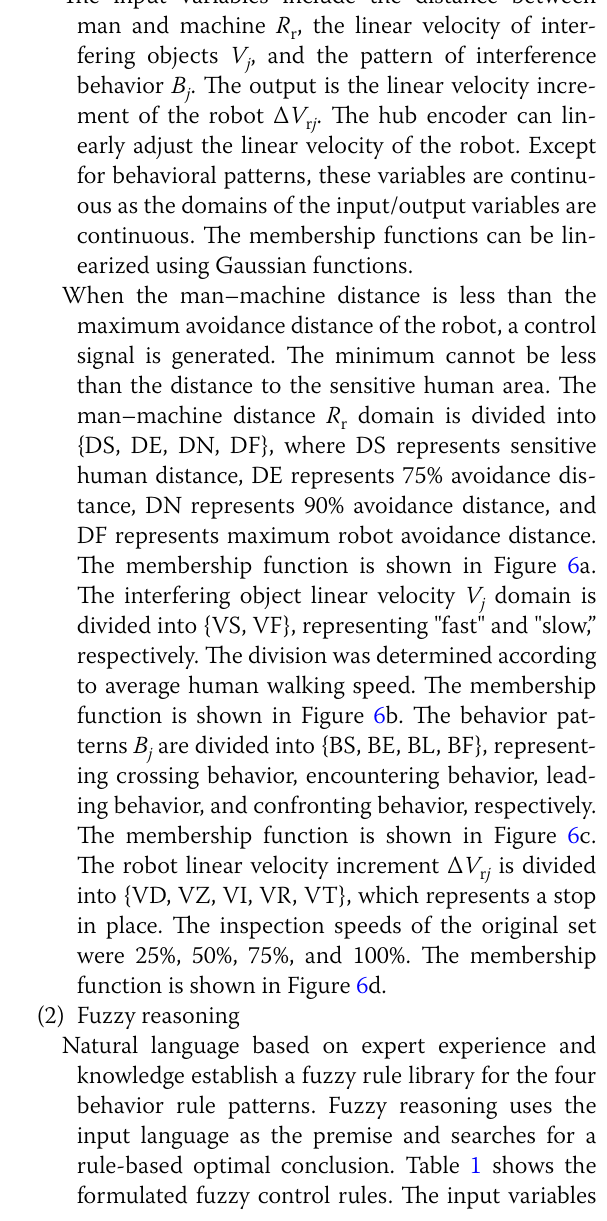
Figure 5 Four man–machine behavior